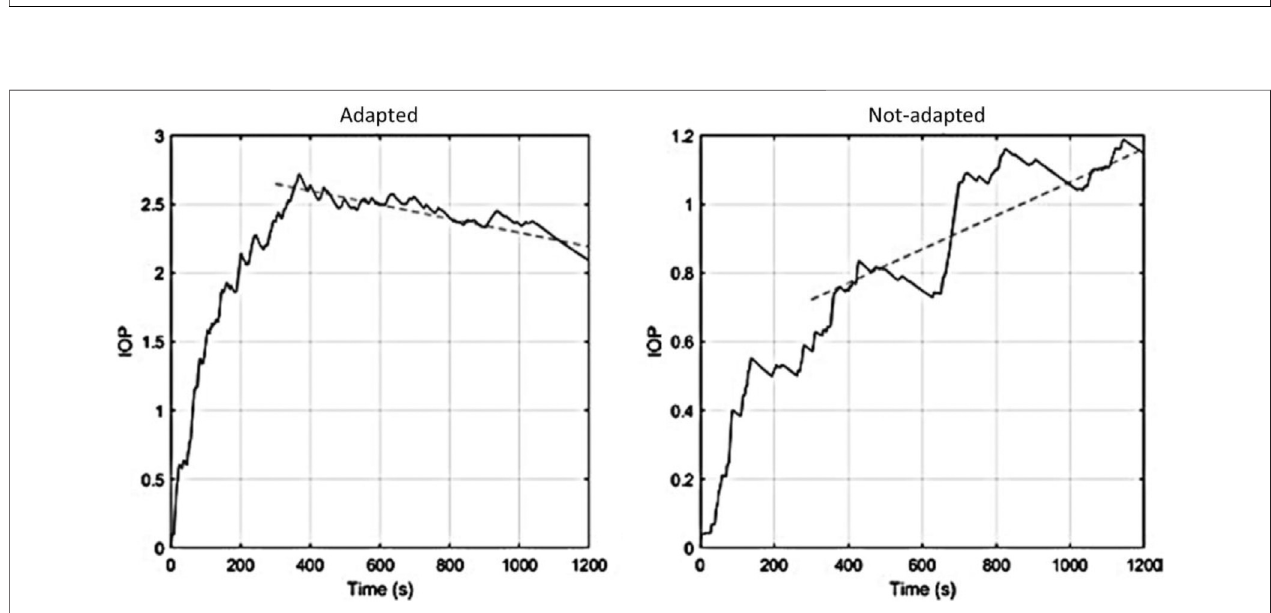
FIGURE 5 | Twoexamples ofdriving performances measured by individual IOP. Participant in panel (A) adapted to the simulator after about 400 s, whereas panel (B) did not.